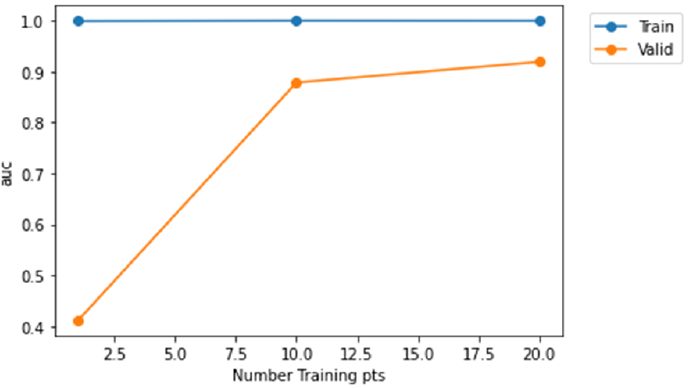
Figure 13. Representation of AUC values at different training points for Model-1.